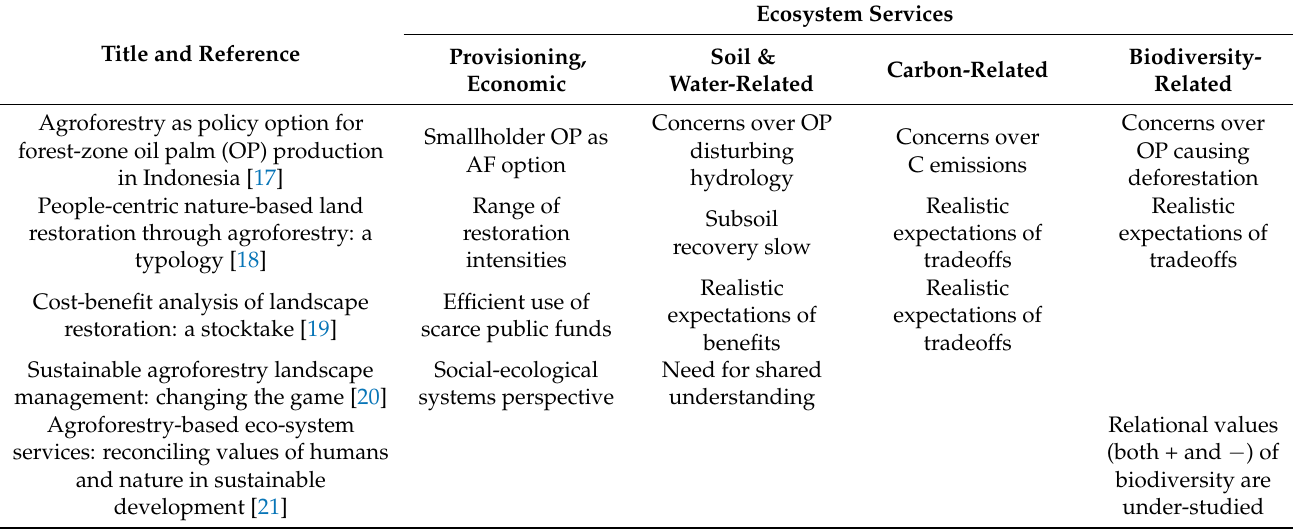
Table 3. Papers analyzing efforts to transcend the existing forestry versus agriculture dichotomy in land